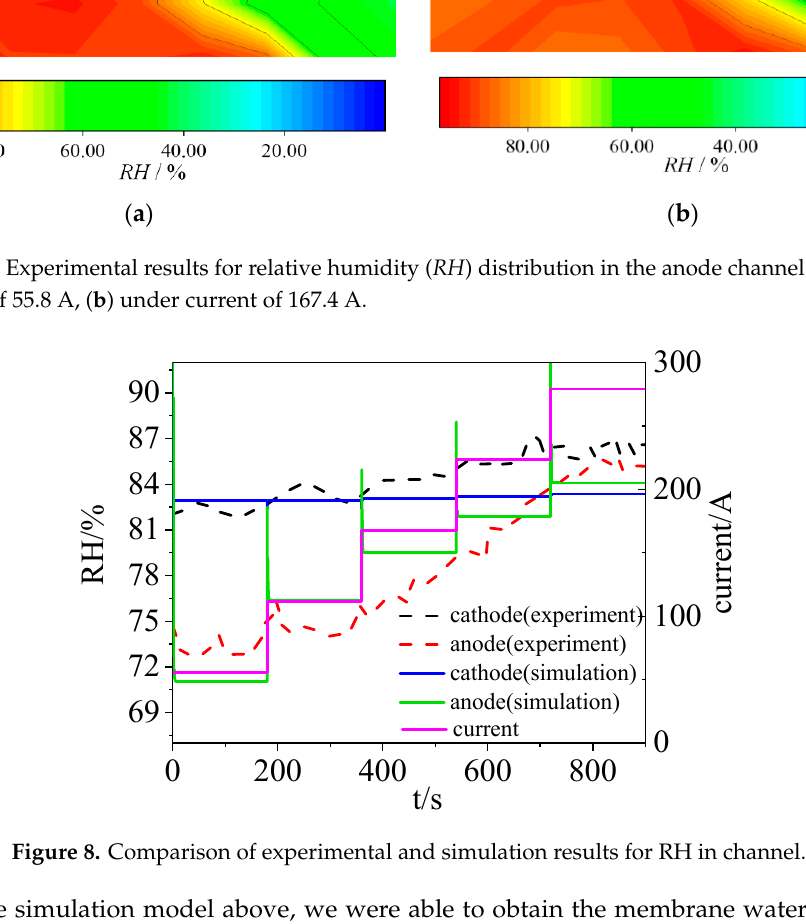
Figure 7. Experimental results for relative humidity ( RH ) distribution in the anode channel: ( a ) under current of 55.8 A, ( b ) under current of 167.4 A.